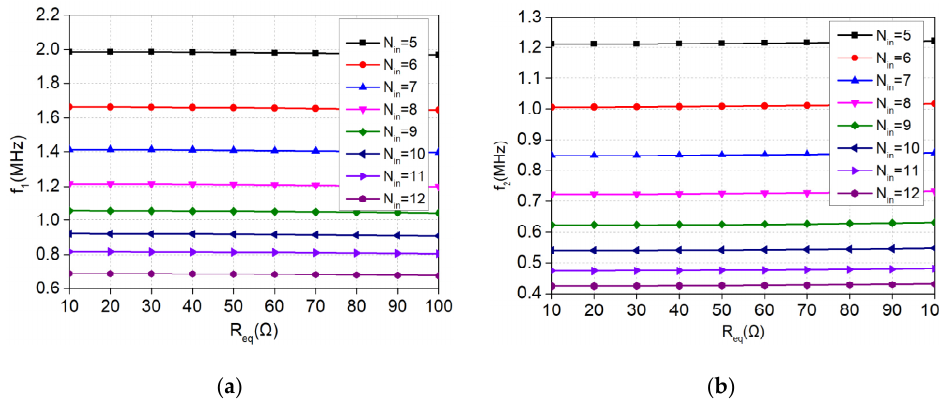
Figure 8. The variation of system operating frequency with N in and R eq . ( a ) The variation of f 1 with N in and R eq . ( b ) The variation of f 2 with N in and R eq .